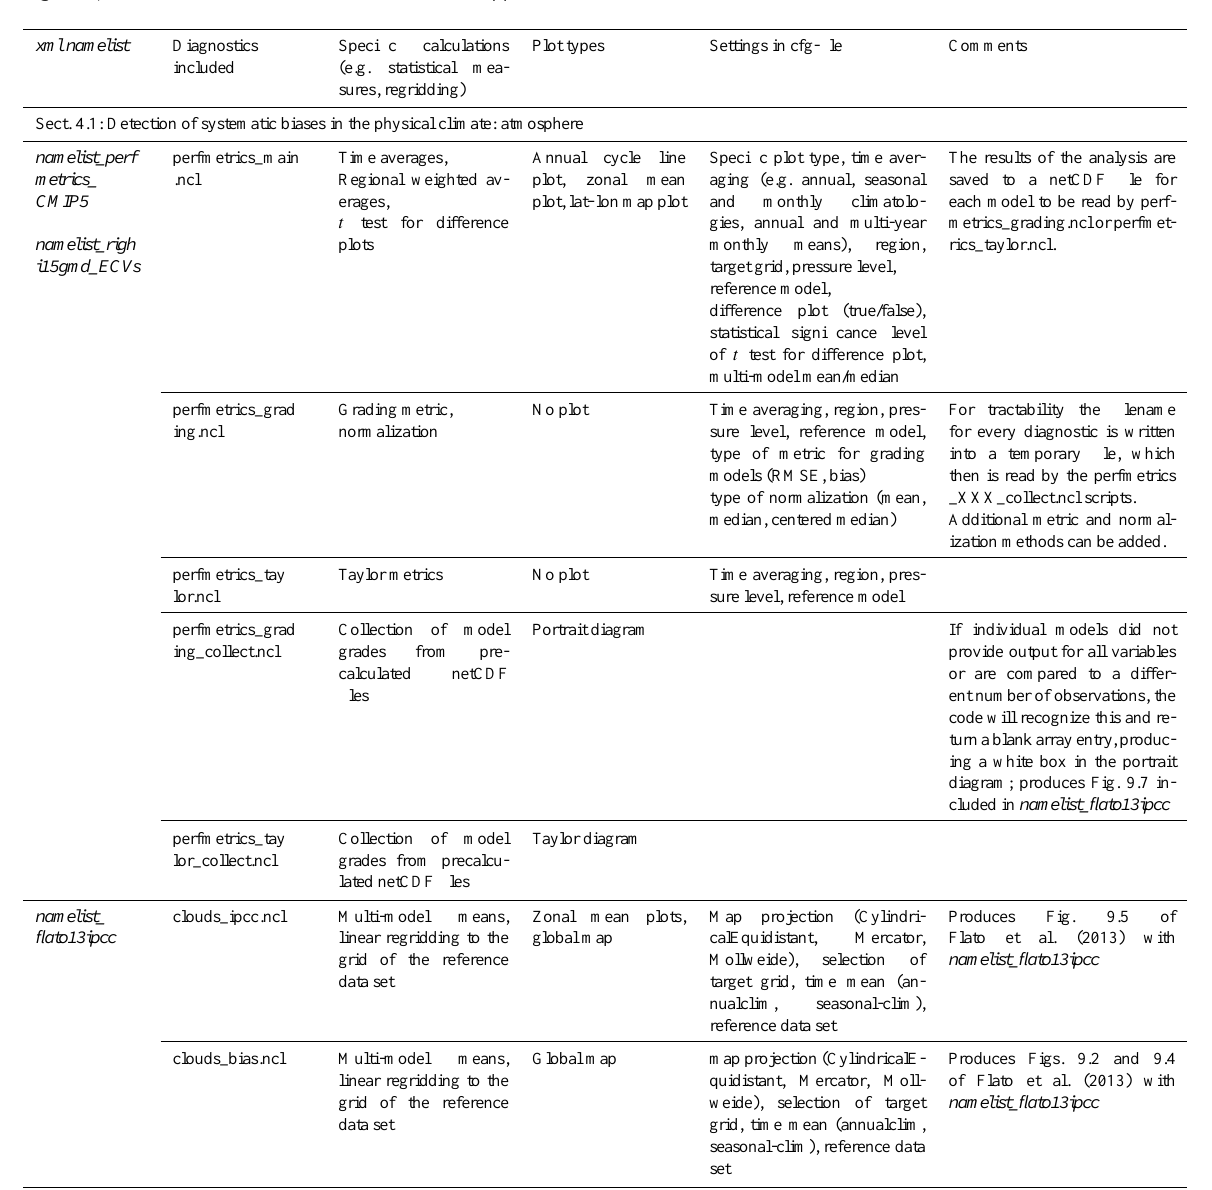
Table 2. Overview of the diagnostics included for each namelist along with specific calculations, the plot type, settings in the configuration file (cfg-file), and comments. See also Annex C in the Supplement for additional